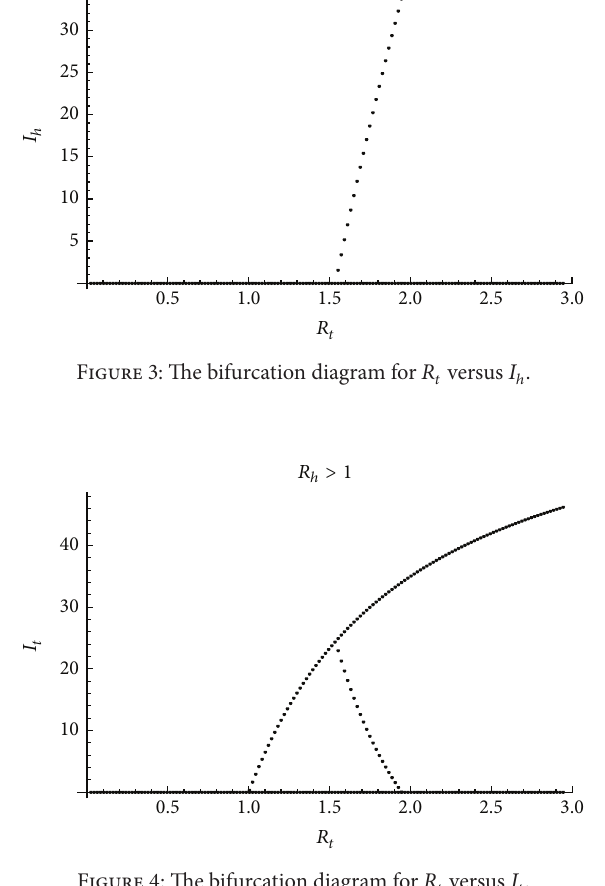
Figure 4: The bifurcation diagram for 𝑅 𝑡 versus 𝐼 𝑡 .